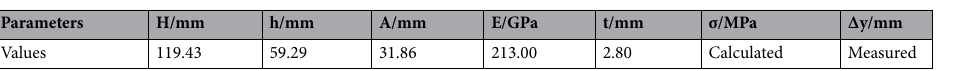
Table 2. Parameters of a four-point bending loading